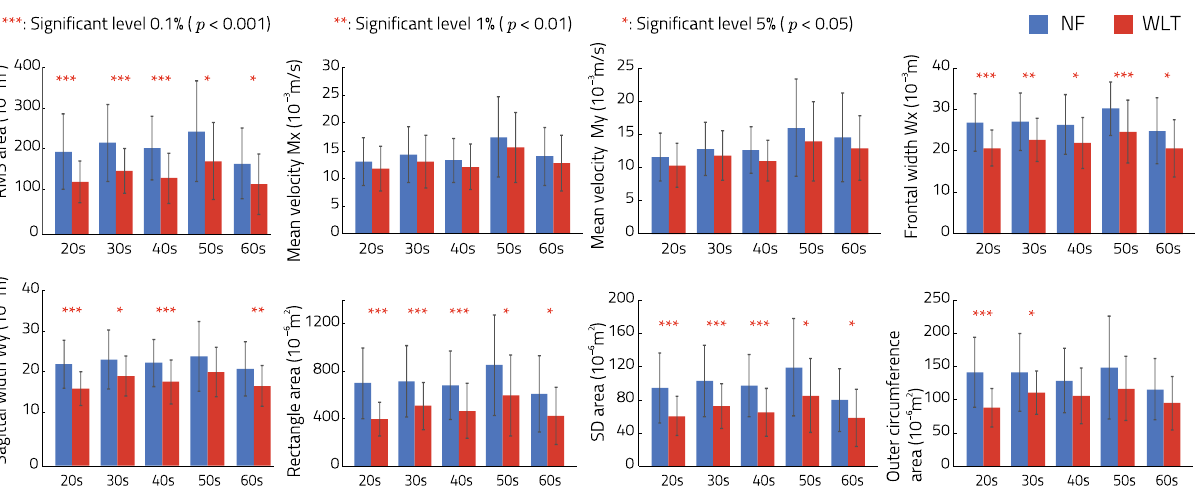
Figure 7. Experimental results for 150 subjects with WLT (experiment 3). NF (blue bars) represents results from the condition of no contact anywhere with the hand moving to touch the virtual partition without feedback in a closed-leg stance. WLT (red bars) represents results from a closed-leg stance with the WLT device. Each graph shows COP indices for RMS area, mean velocity for the frontal and sagittal sides, frontal and sagittal width, rectangle area, SD area and outer circumference area. ***, ** and * represent significant differences of 0.1, 5 and 1%,